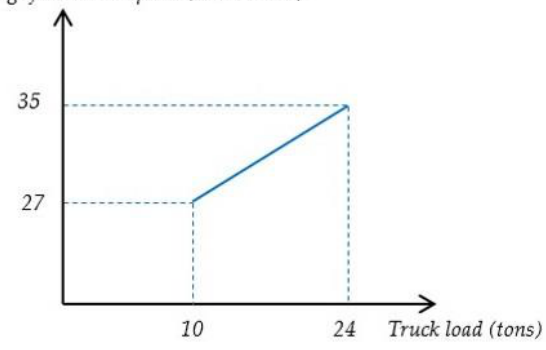
Figure 3. Linear function of average fuel consumption vs. total weight for regional traffic (Data source: Volvo Corporation, 2018).